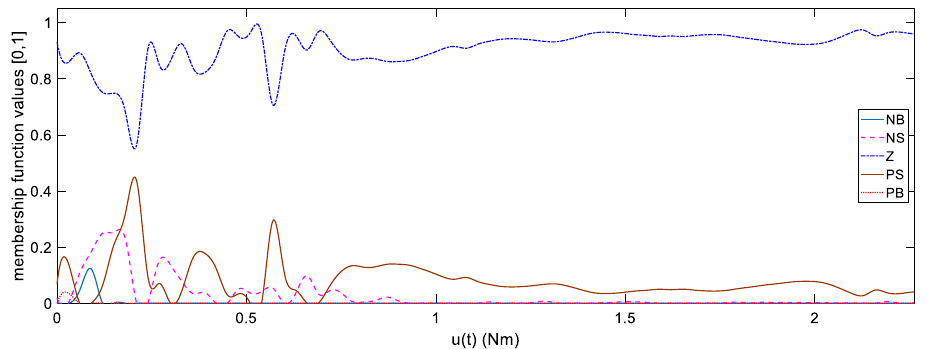
Figure 18. Membership function value of the fuzzy set u(t) corresponding to the physical value domain of u(t) is chosen to be 3 times larger than the value in Table 6.